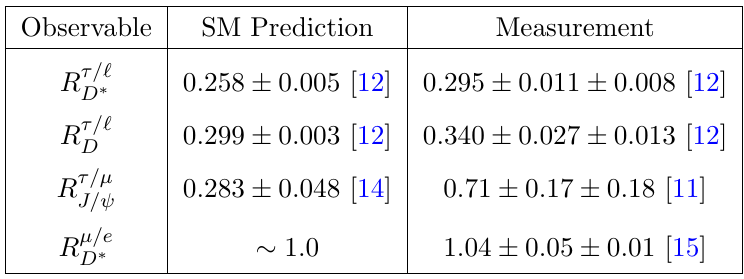
Table 1 . Measured values of observables that suggest NP in b ! c(cid:28) (cid:0) (cid:22) (cid:23)